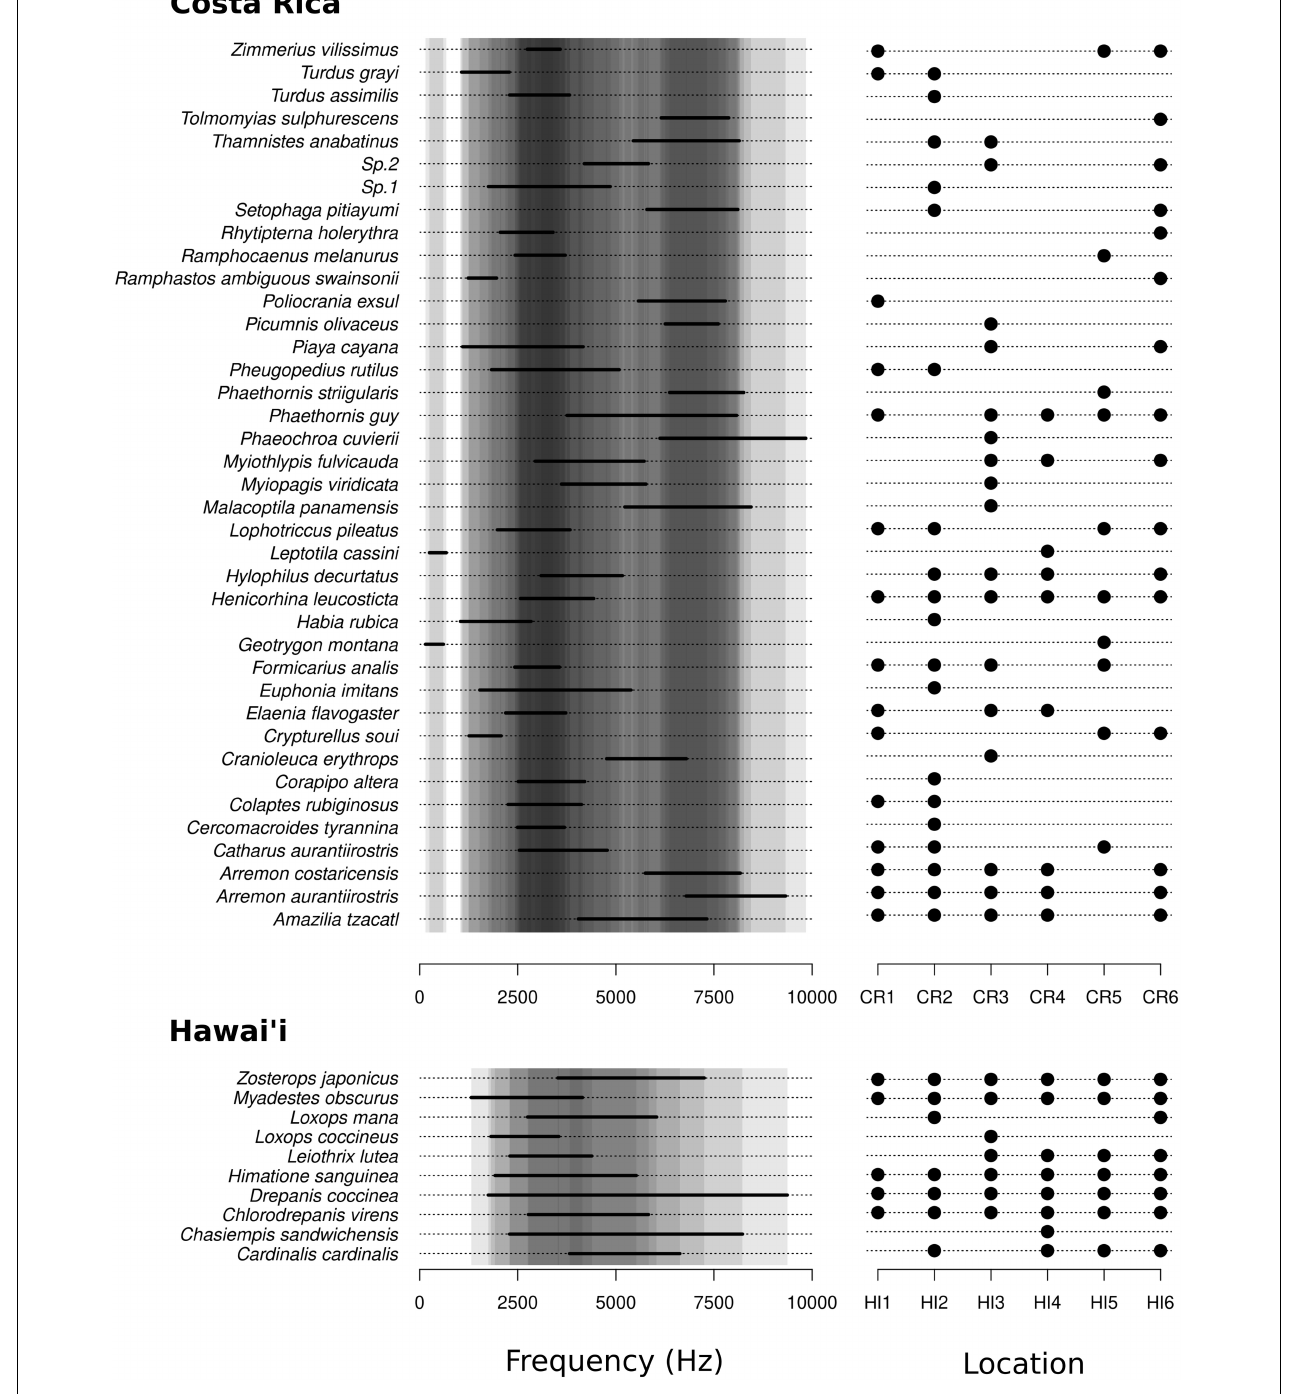
FIGURE 2 | List of detected species with their vocalization ranges ( left figures) and their locations of occurrence ( right figures) in Costa Rica and Hawai‘i. On the left figures, gray background represents potential overlapping in a given frequency, the darker the background, the higher the number of species using this frequency.